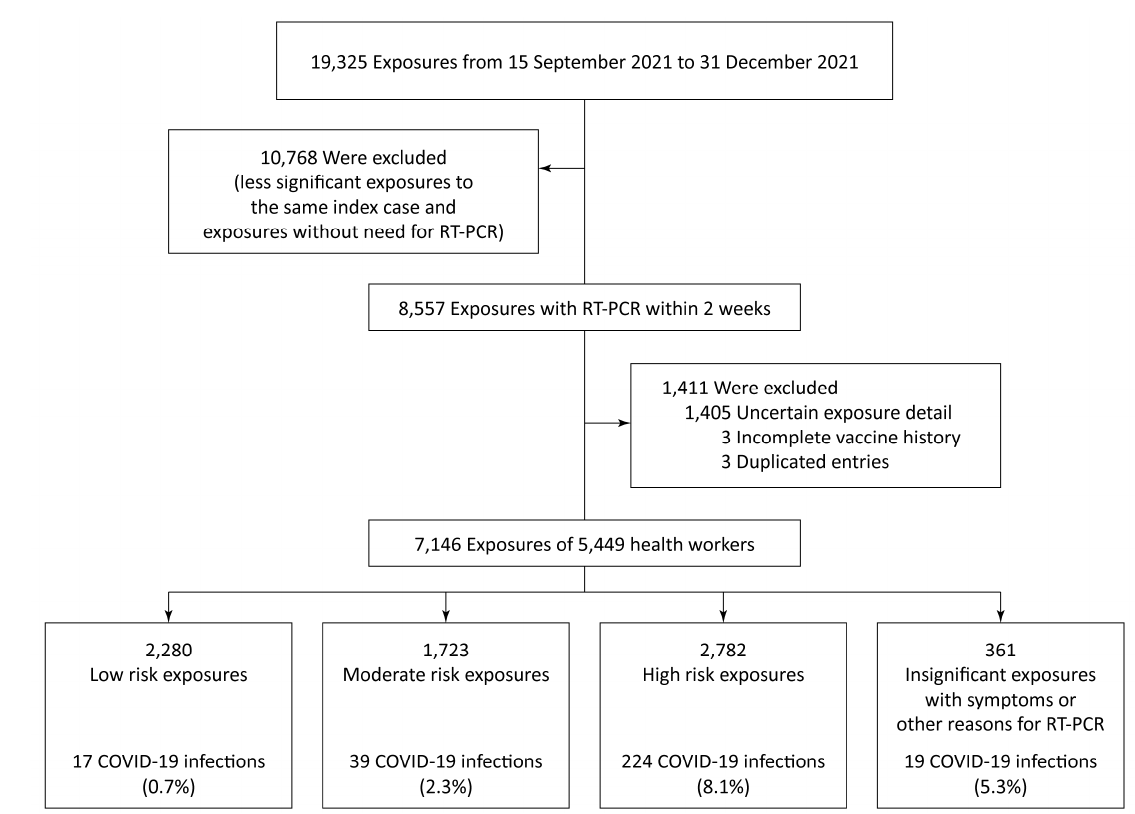
Figure 1. Consort type study flow diagram. Table 1. Characteristics of occupational exposures to COVID-19 of hospital